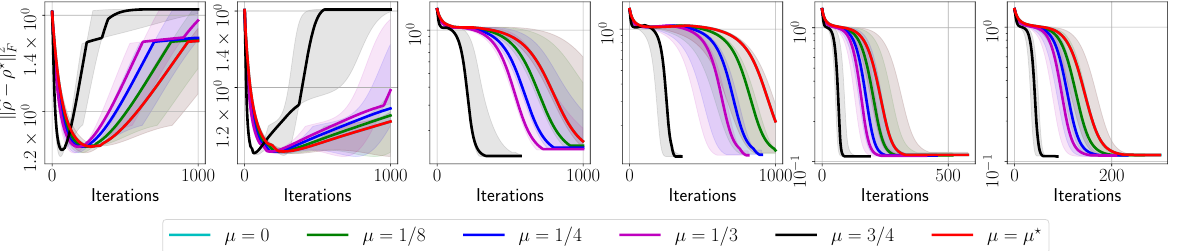
Figure A13. Target error list plots for reconstructing Hadamard ( 6 ) circuit using real measurements from IBM Quantum system experiments.